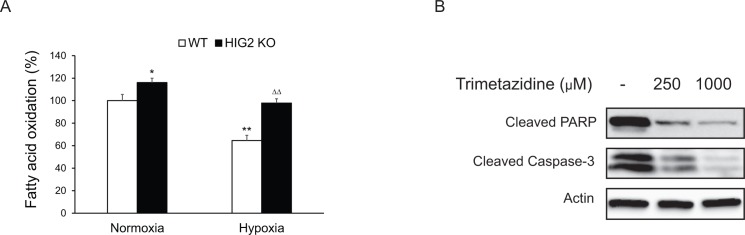
Fatty oxidation and apoptosis in HCT116 cells.(A) Fatty acid oxidation was measured based on the 3H2O production from [9,10- 3H]-oleate. Cells were incubated with 2 ml of BSA-complexed oleate (0.2 mM unlabeled plus 2 μCi/ml of [9, 10- 3H] oleate and 0.2% BSA) in 10% FBS medium. Twenty four hours later, the medium was replaced with fresh 10% FBS medium without oleate and incubated in normoxia or hypoxia for 24 hr. Then cells were cultured in fresh serum-free medium containing 0.2% BSA for another six hours and the medium was collected for measuring 3H2O production. *p<0.05, **p<0.01, vs. Normoxia WT; ∆∆p<0.01 vs. Hypoxia WT. n = 3 biologically independent experiments. Graphs represent mean ± SD, and were compared by two-tailed unpaired Student t-test. (B) HCT116 HIG2 KO cells were cultured under hypoxia in the presence or absence of trimetazidine for 48 hr. Cell apoptosis was determined by immunoblotting.